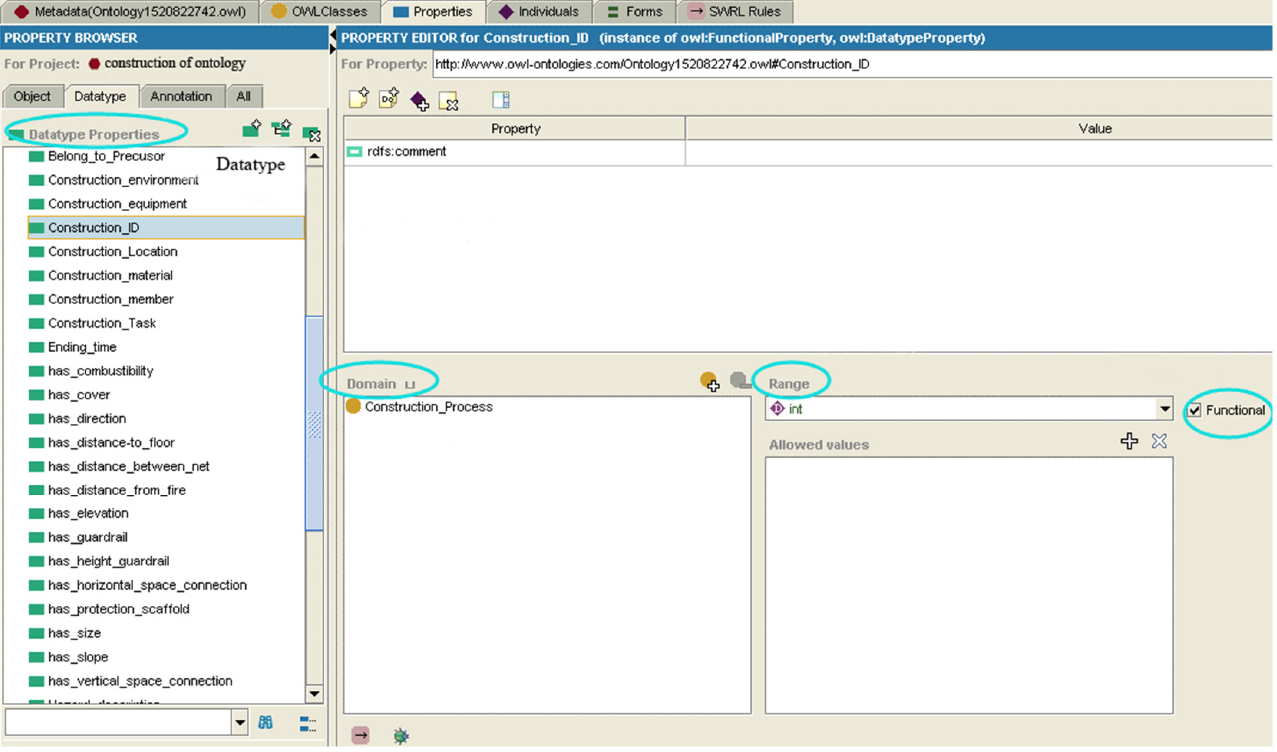
Figure 4. Various data type attribute definition